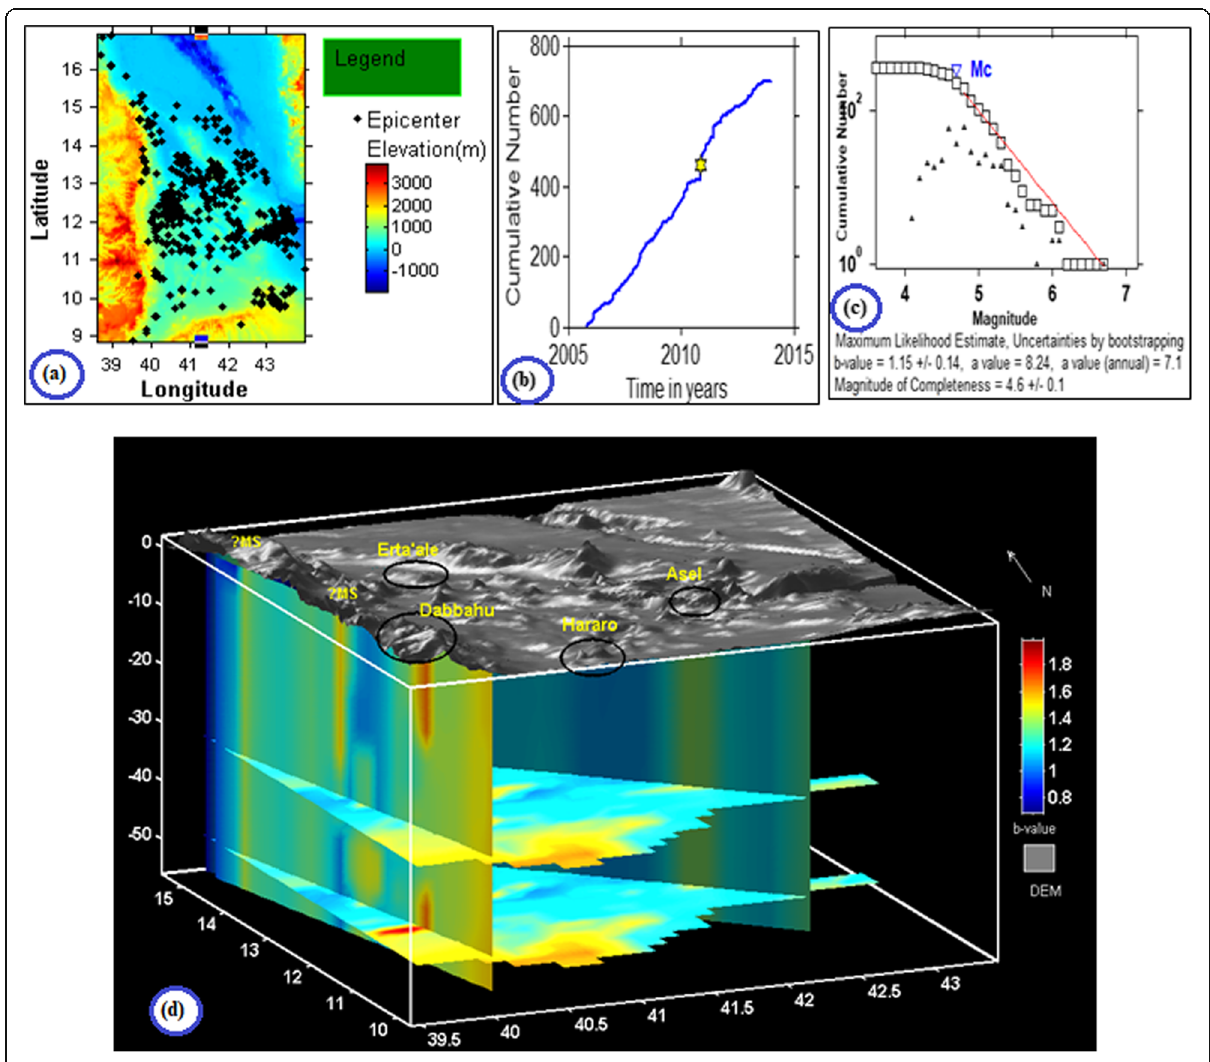
Fig. 8 Afar Rifts separately: ( a ) Seismicity map for Afar Rift used for this study ( b ) Cumulative number of events vs time-straight-line trend -relatively complete ( c ) the average value of Seismicity parameters ( a , b , and Mc) of the region by maximum likelihood solution for ni = 150, Mmin = Mc = 4 ( d ) 3D map of b-values of Afar rift with the Dabbahu,Hararo, Erta ’ ale and others Volcanoes showed posted over DEM from Fig.